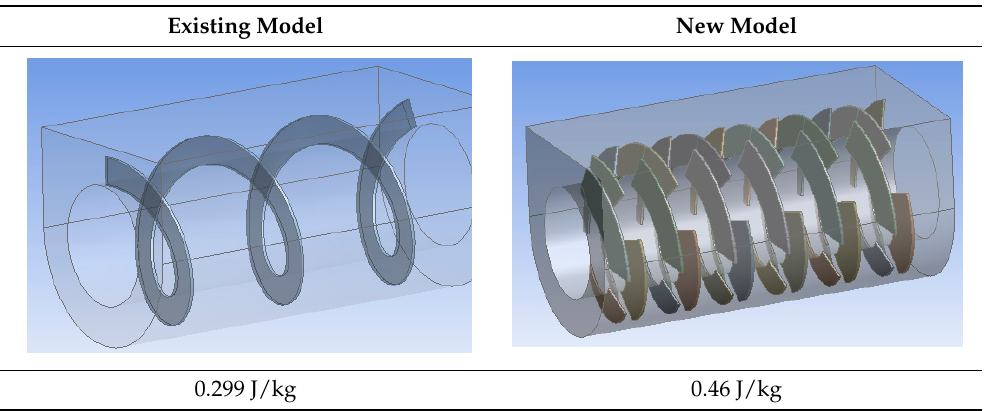
Table 7. The result obtained from response surface.